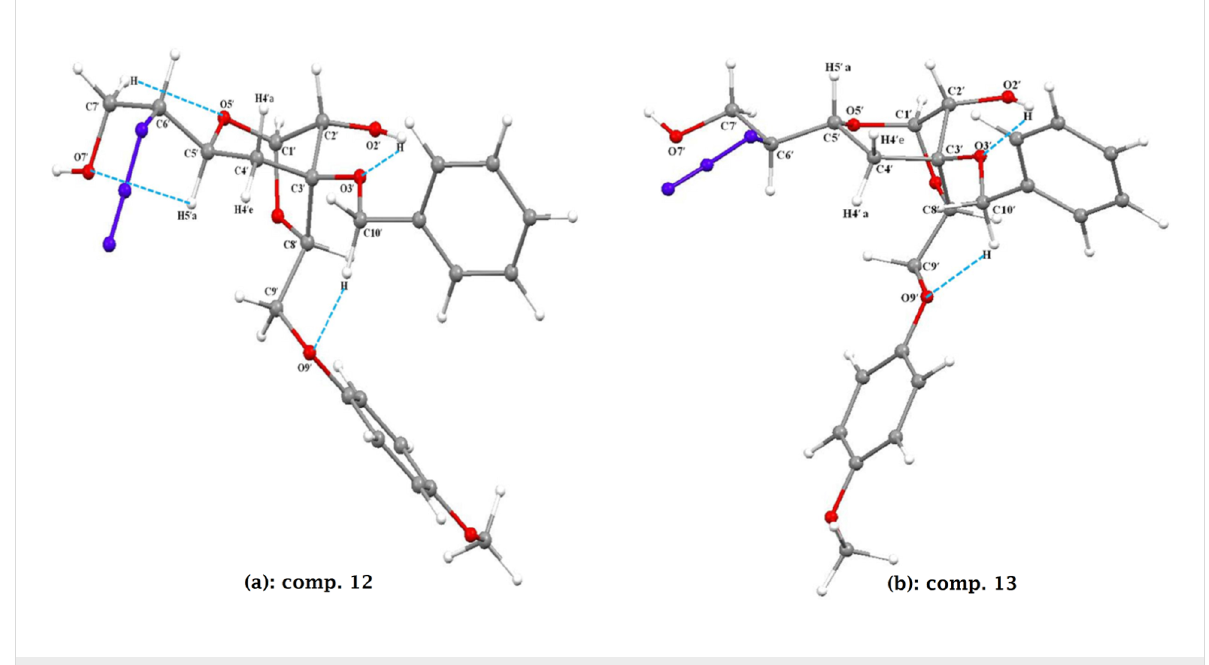
Figure 3: Geometrically optimized conformation of 12 and 13 respectively by DFT study.